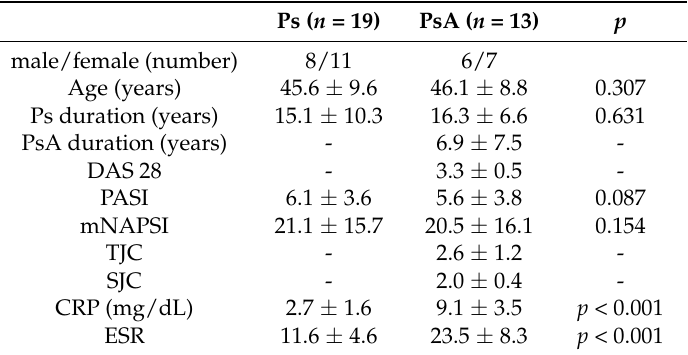
Table 1. Age and clinical characteristics of the